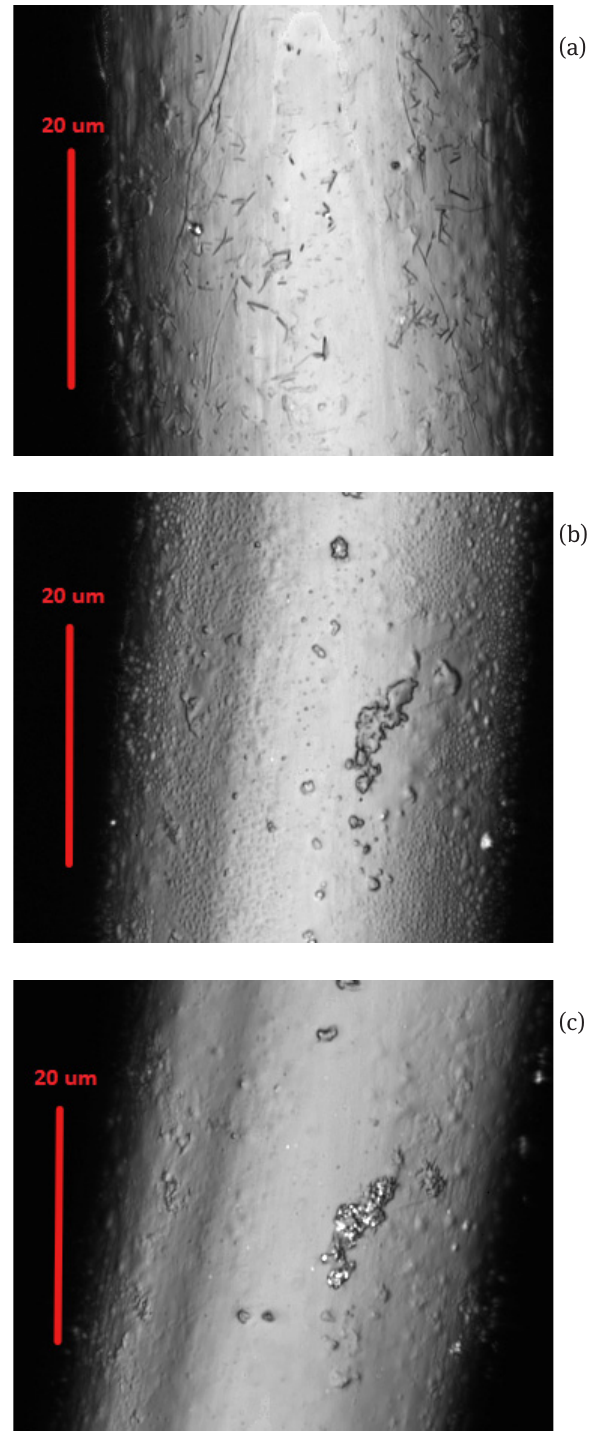
Figure 10: a) The surface of PP fibre without surface treatment b) The surface of PP fibre with plasma surface treatment in DCSBD.c) The surface of PP fibre with plasma surface treatment in DCSBD after 24 hours in water